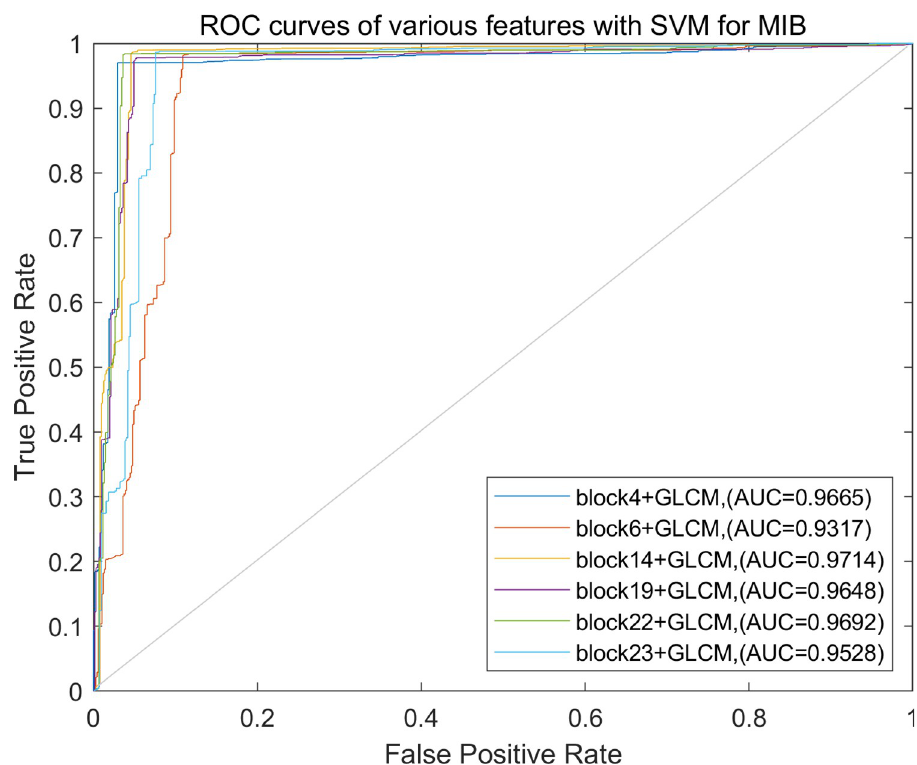
Fig 8. ROC curves of different feature combinations for MIB